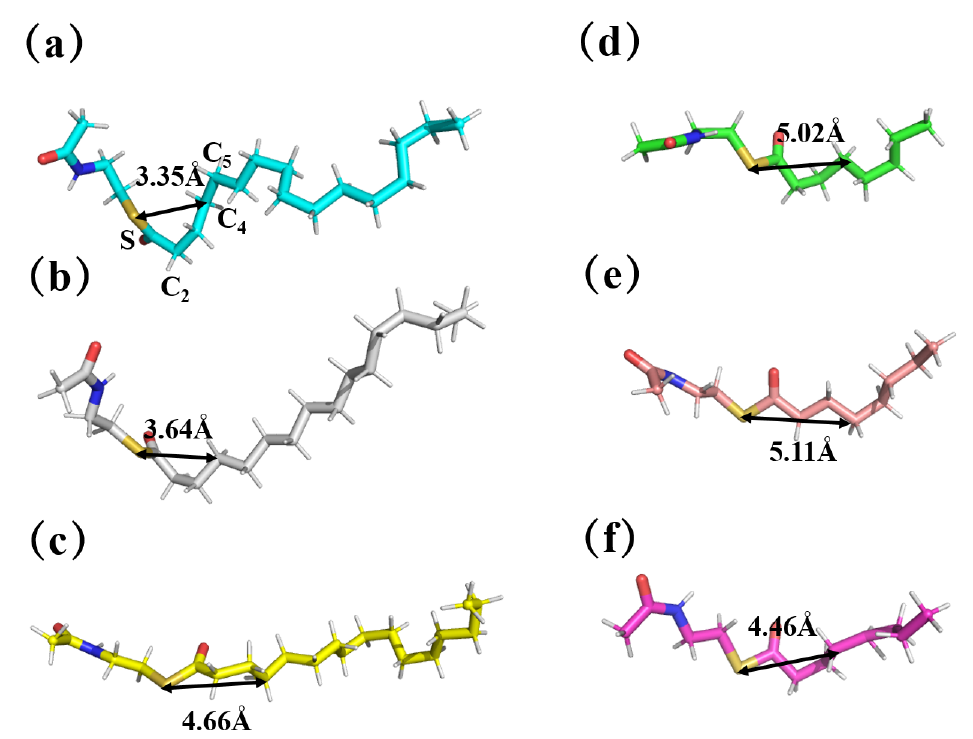
Figure 8. Conformational comparison of substrates in different complexes. The